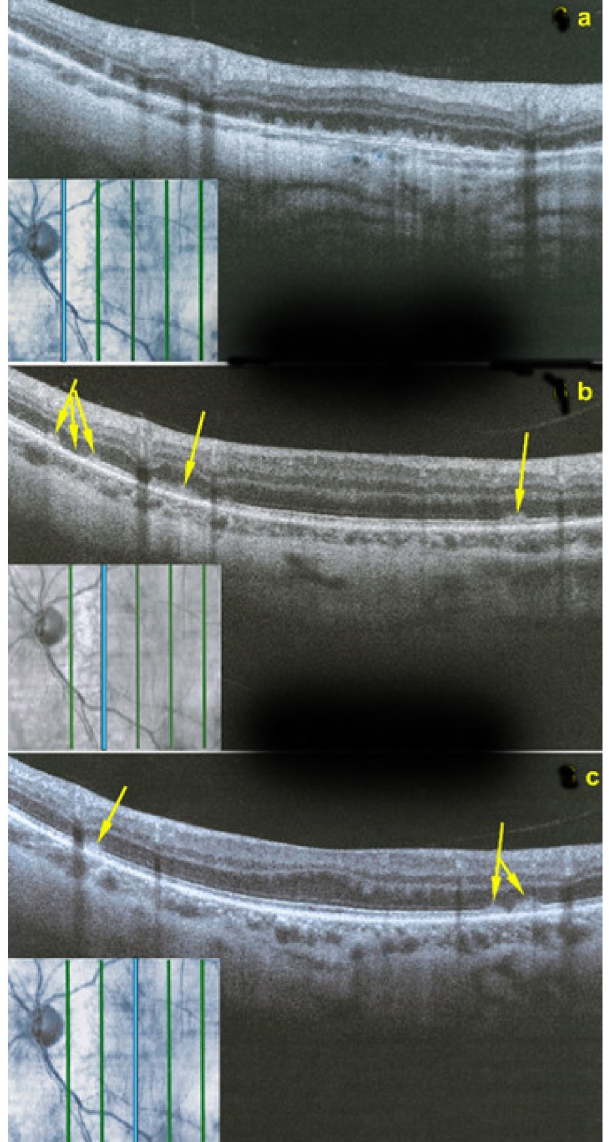
Figure 22. OCT scans of MFC at presentation through ICGA hypofluorescent area ( a ), at the border of ICGA hypofluorescent area ( b , c ). The top set of figures ( a ) represents a scan going through the ICGA hypofluorescent area (FAF hyperautofluorescent) showing damaged photoreceptor outer segments with clumps throughout the whole scan. ( b , c ) show scans at the border of the ICGA hypofluorescent (FAF hyperautofluorescent) area with only sectorial damage to the photoreceptor outer segments (arrows) and almost normal ellipsoid zone on the most distant scan from ICGA hypofluorescent (FAF hyperautofluorescent)